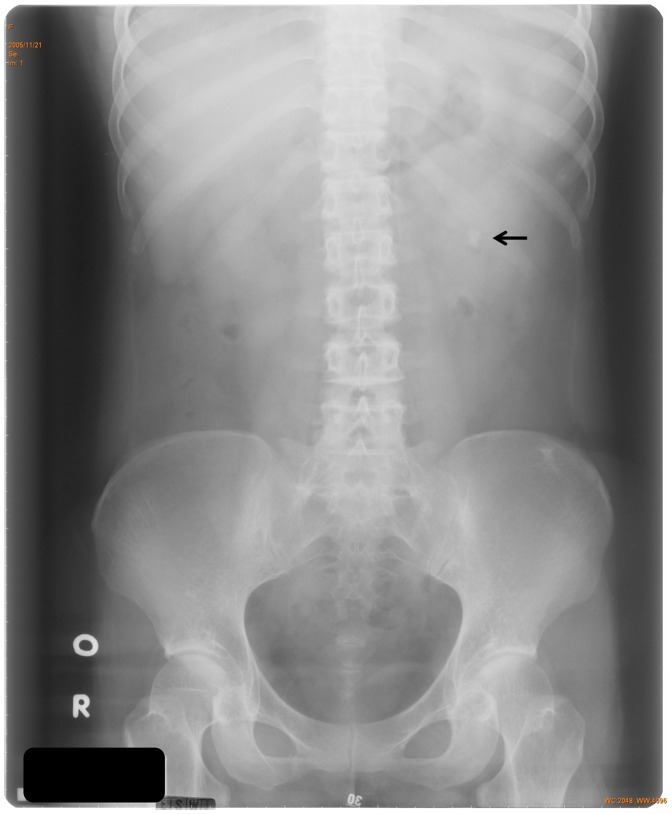
Radiography of the kidneys and urinary bladder.A radio-opaque stone measuring 11×6 mm in size in the central portion of the left kidney (arrow).